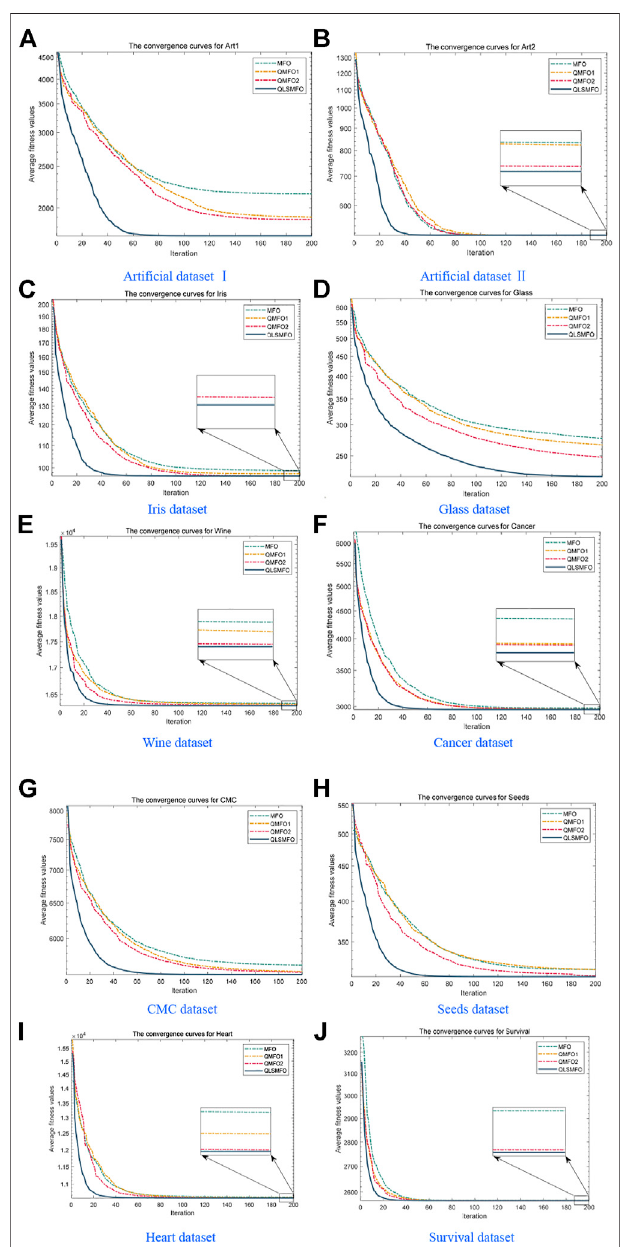
FIGURE 10 | Convergence curves of MFO, QMFO1, QMFO2, and QLSMFO on the 10 datasets. (A) Arti fi cial Dataset I (B) Arti fi cial Dataset II. (C) Iris dataset. (D) Glass dataset. (E) Wine dataset. (F) Cancer dataset. (G) CMC dataset. (H) Seeds dataset. (I) Heart dataset. (J) Survival dataset.